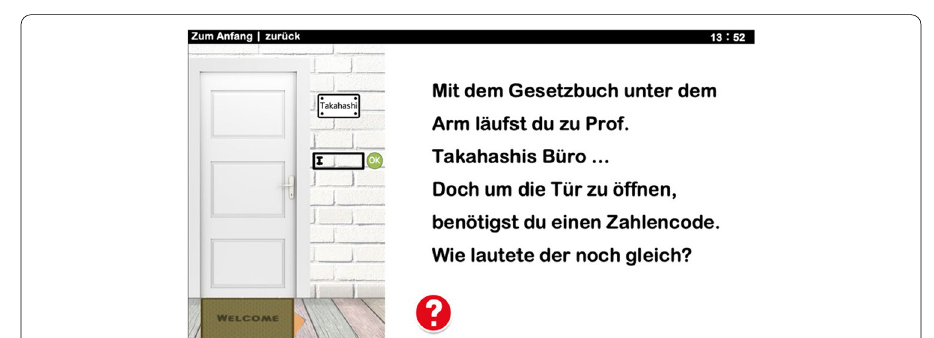
Fig. 3 Example of the open-the-door puzzle; the red button with the question mark displays a hint when clicked; at the upper right corner is the